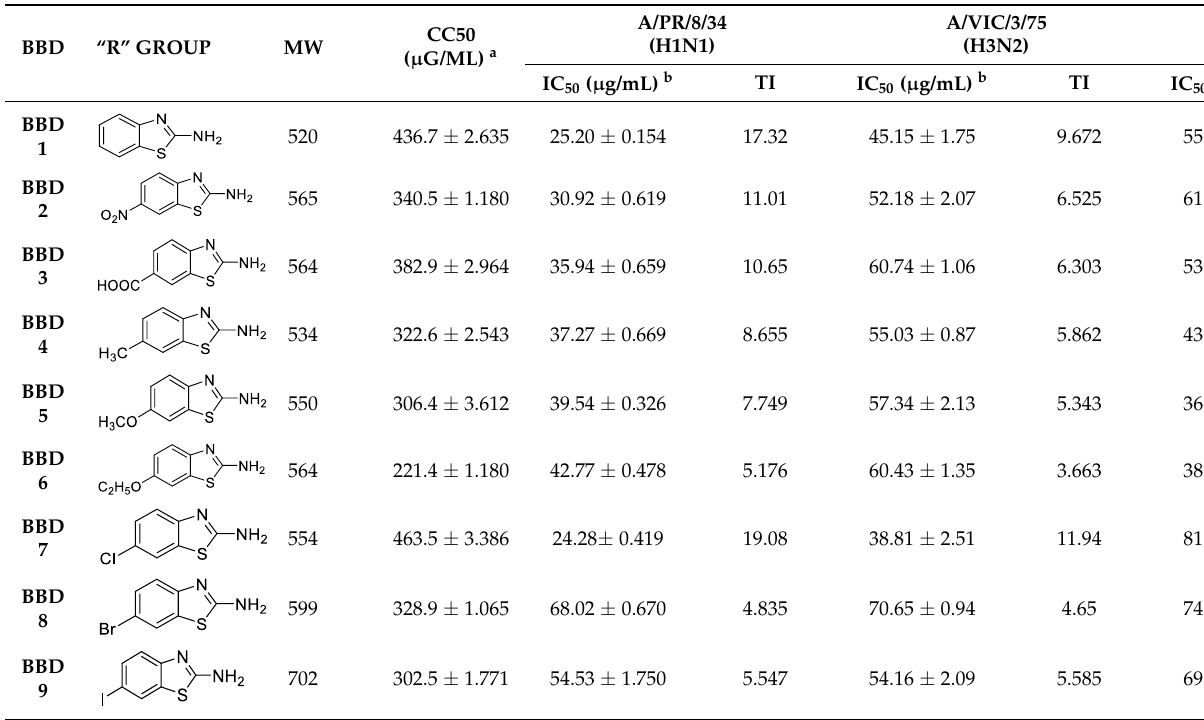
Table 1. In vitro optimization of berberine–benzothiazole-based inhibitors.